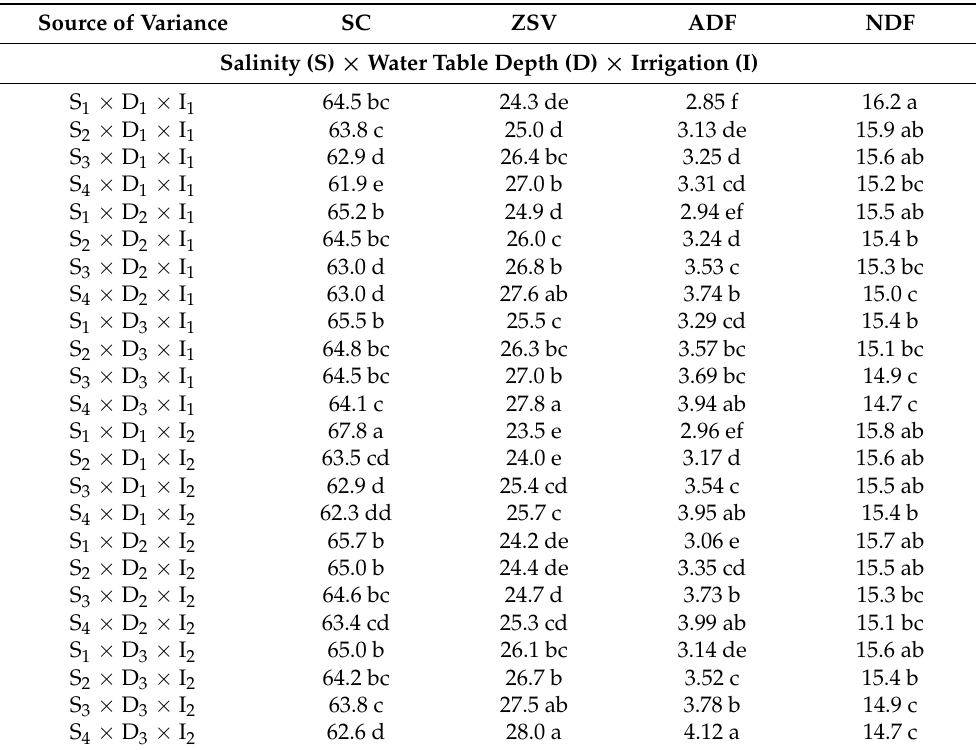
Table 6. The mean of the two years for the interaction effects of the salinity level × water table depth × irrigation on the wheat parameters